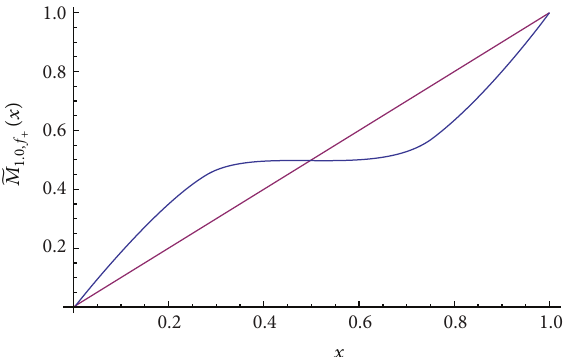
̃𝑀 𝜆 = 1.0 and 𝑓 𝑓 + ,𝜆 for